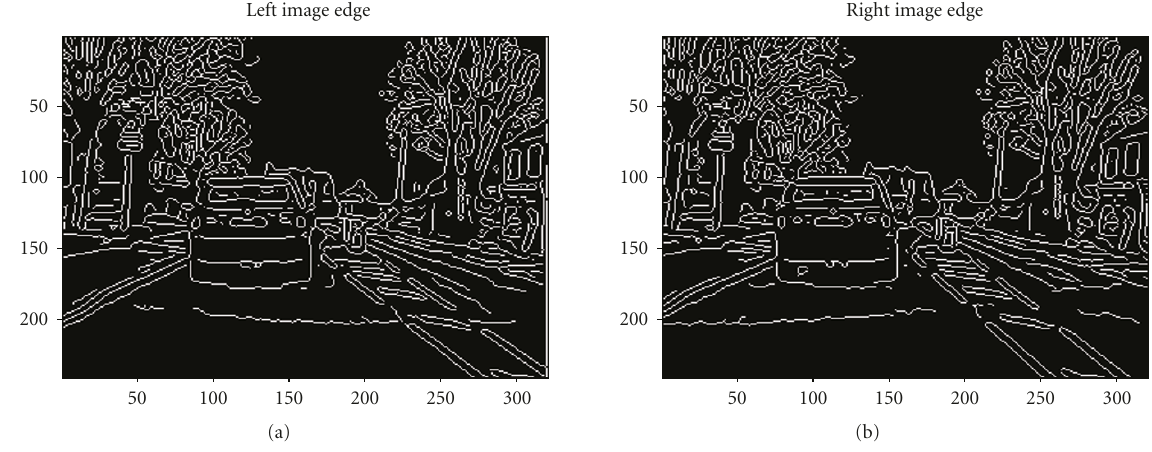
Figure 2: Edge image of the stereo image pair in Figure 1(a).